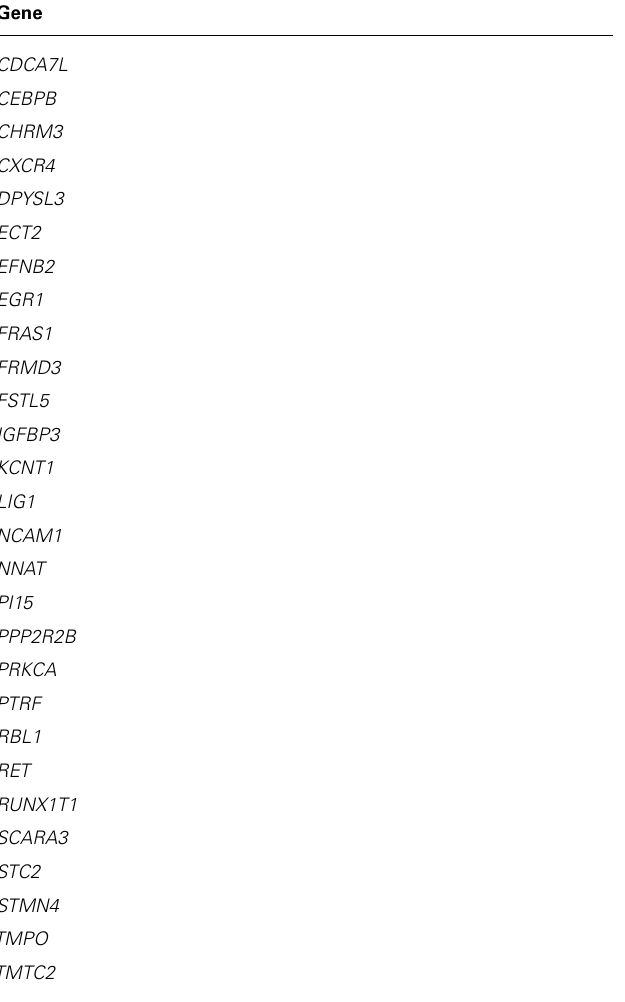
Table 1 | Overlap between the FOXP2 targets list provided in Konopka etal. (2009) and the 691 genes found to be differentially